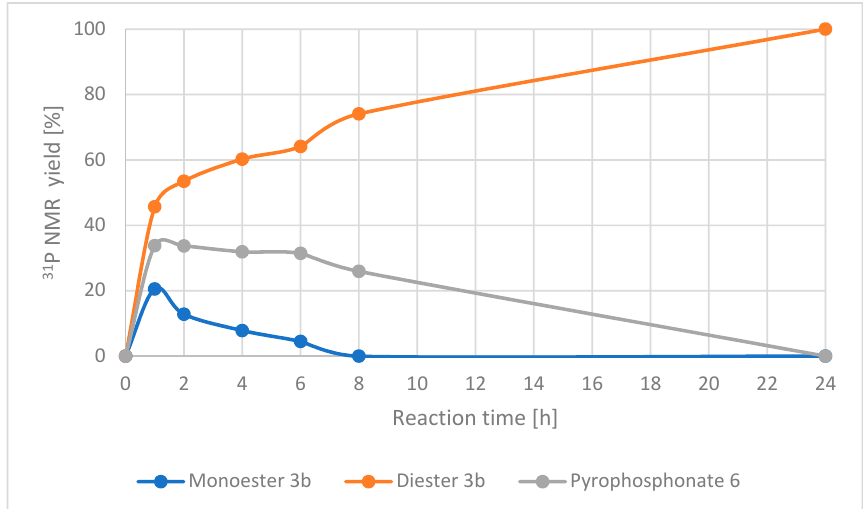
Figure 4. Changes in concentration of products with time.